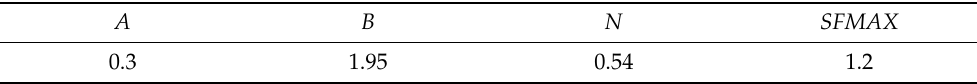
Figure 16. The relationship between p ∗ and σ ∗ . Table 5. The limit surface parameters of